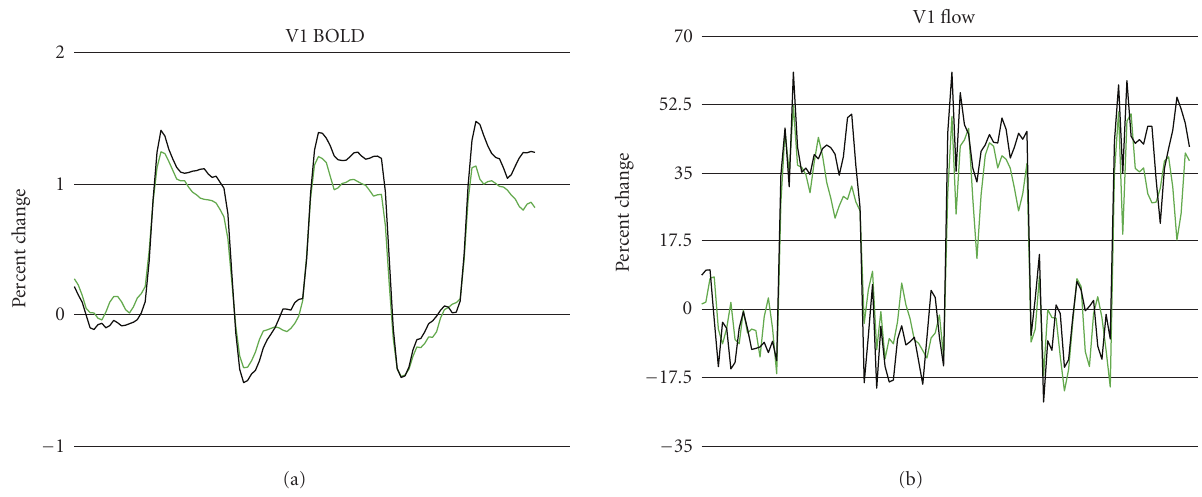
Figure 2: BOLD and flow signals (expressed as percent change; black = binocular, green = monocular) in response to monocular and binocular visual stimulation, averaged over all subjects (6 subjects × 4 averages per subject = 24 averages per signal). Initial overshoot and poststimulus undershoot are observed in BOLD signal for both monocular and binocular stimulation, as is typical for checkerboard stimulation.